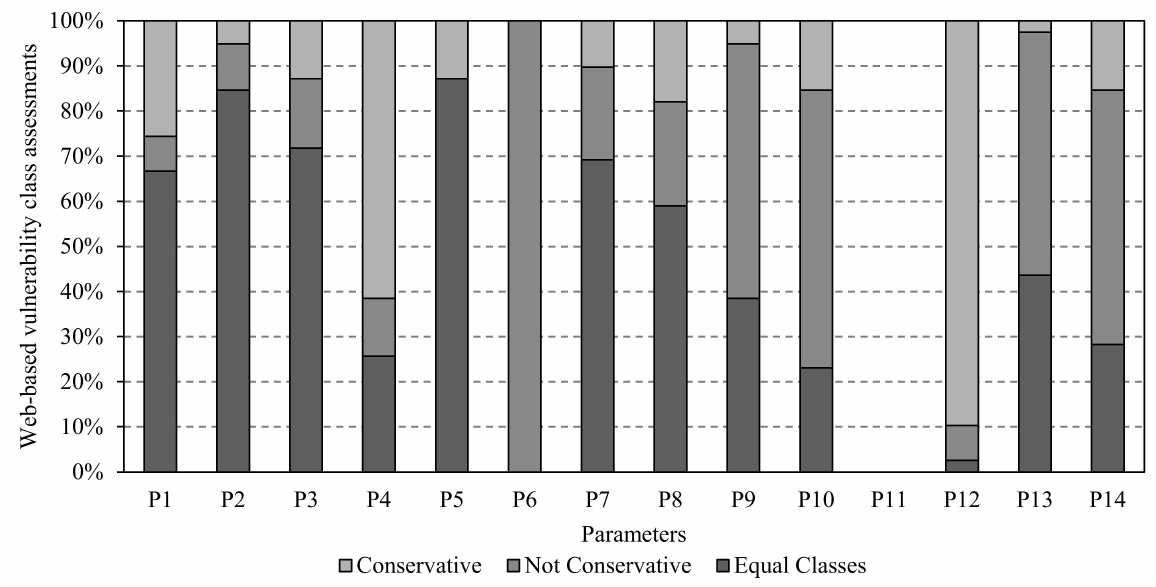
Figure 7. Comparison between the reference vulnerability index and the classes assigned using remote surveying.